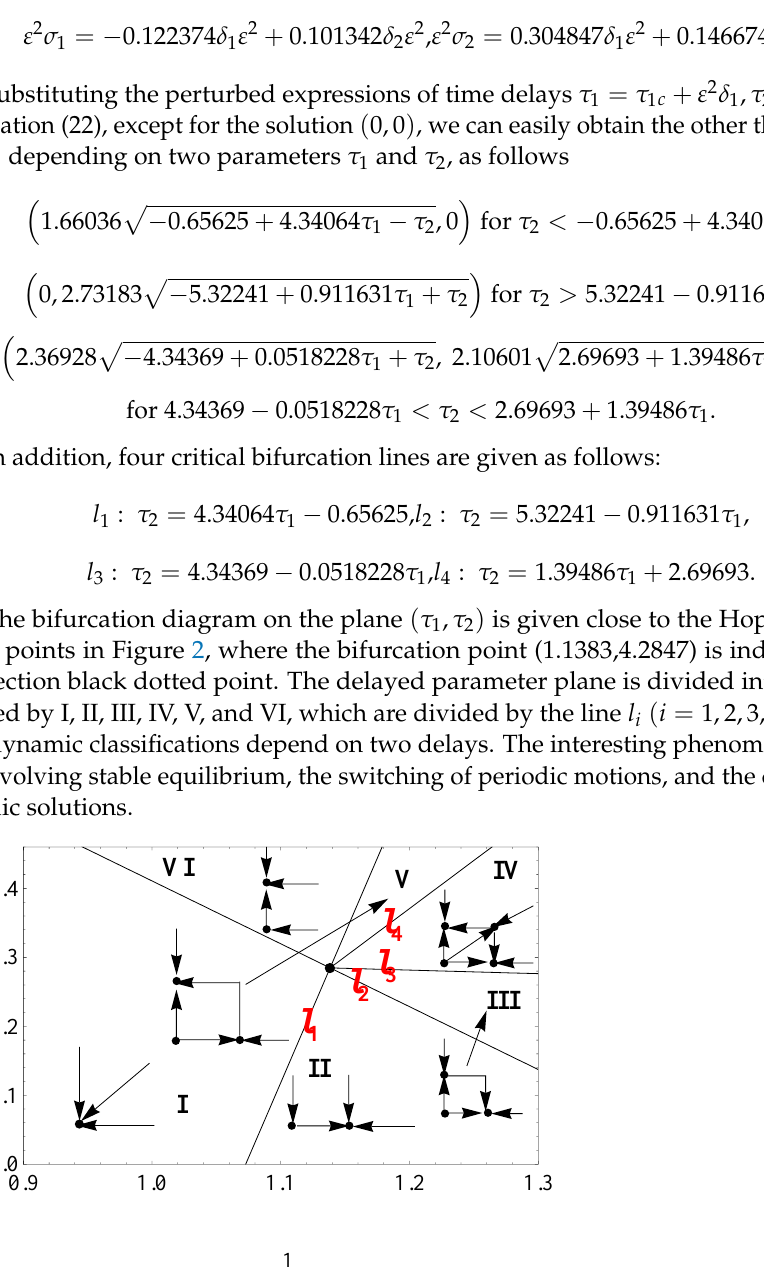
and the trivial equilibrium point. A periodic solution has high frequency and